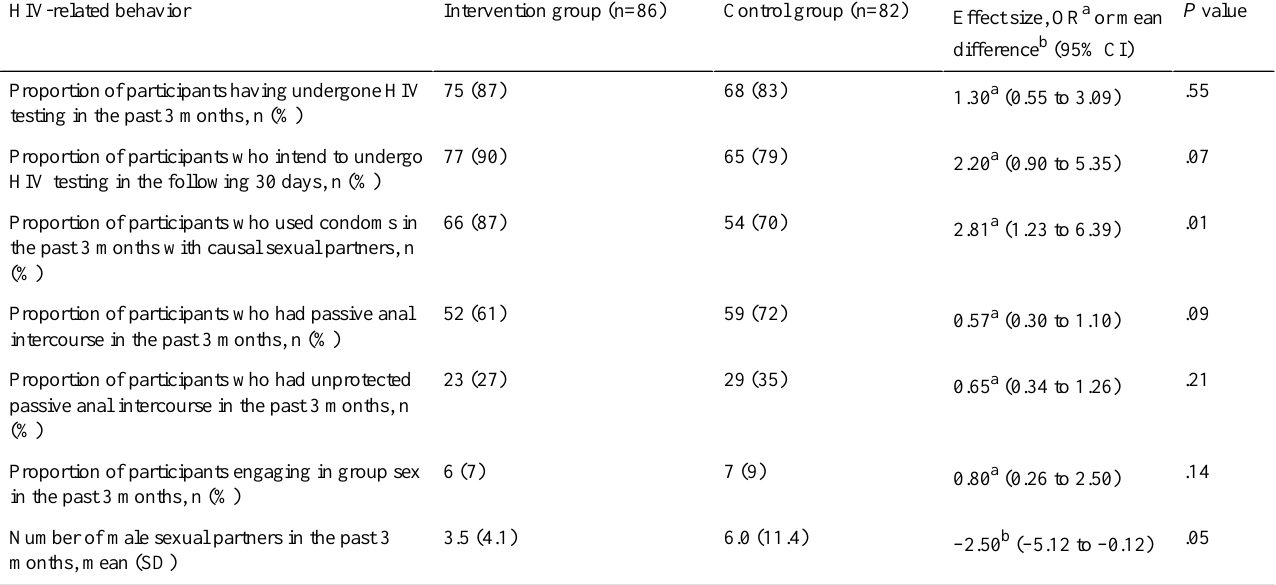
a OR: odds ratio and 95% CI values have been used to indicate the effect size. b Mean difference and 95% CI values have been used to indicate the effect